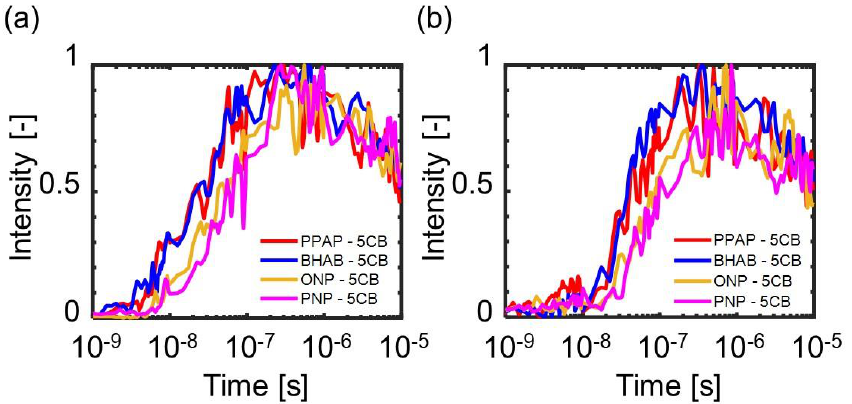
Figure 8. The temporal changes of the amplitudes of the stripe contrast in the refractive index images for each sample: ( a ) ∆ n e ( t ) response; ( b ) ∆ n o ( t ) response. The time axis is shown in a logarithmic time scale. The pump intensity was 2.67 mJ/pulse. The samples were 5CB doped with PPAP, BHAB, o − NP, and p − NP. The examples of overall responses are shown in Figure S3b.